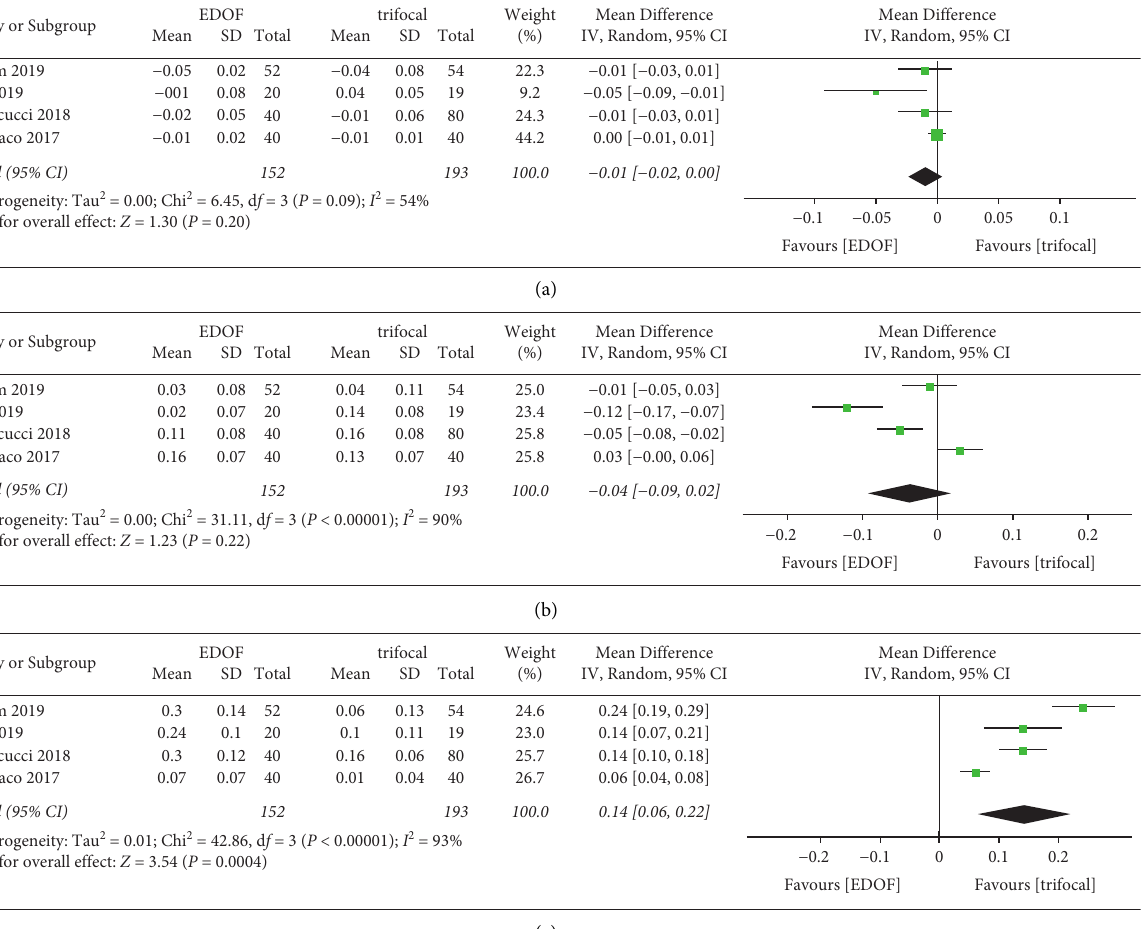
Figure 7: Forest plot of monocular corrected visual acuity. (a) Corrected distance visual acuity; (b) distance corrected intermediate visual acuity; and (c) distance corrected near visual acuity. EDOF, extended depth-of-focus; SD, standard deviation; CI, confidence interval; IV, inverse